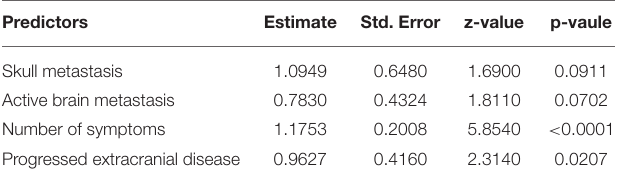
TABLE 2 | Coefficients of predictors in model A.